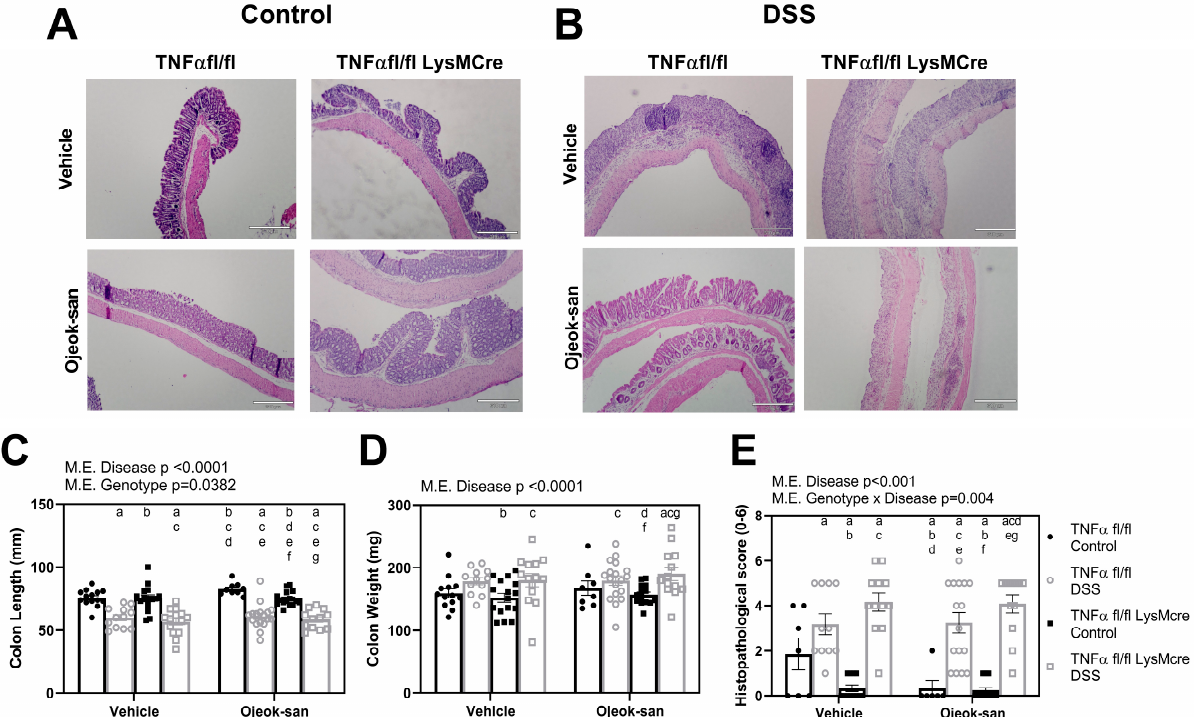
Figure 2. Ojeok-san administration does not impact colon size and histopathology in a chemical model of acute colitis. ( A ) Representative H&E staining of colonic tissue from control and ( B ) DSS- treated mice, ( C ) colon length, ( D ) colon weight, and ( E ) colonic histopathological score following acute DSS administration and OJS treatment in TNF α fl/fl and TNF α fl/fl-LysMCre mice. Values are represented as mean ± SEM; n = 8–18 mice per group. Three-way ANOVA followed by uncorrected Fisher’s LSD post hoc test. Letters indicate statistical significance ( p < 0.05) from a TNF α fl/fl Control- Vehicle, b TNF α fl/fl DSS-Vehicle, c TNF α fl/fl LysMcre Control-Vehicle, d TNF α fl/fl LysMcre DSS-Vehicle, e TNF α fl/fl Control-OJS, f TNF α fl/fl DSS-OJS, g TNF α fl/fl LysMcre Control-OJS. Goblet cells in the colon tissue were visualized using an Alcian blue stain (Figure 3A,B). The average number of goblet cells was determined per six crypts, and villus length was measured. DSS treatment was found to decrease villus length and goblet cell number in colitis mice (Figure 3C,D, p < 0.001). An interaction between disease and genotype was found to result in an increased villus length in TNF α fl / fl -LysMcre Control- Vehicle and OJS-treated mice, as well as TNF α fl / fl Control-OJS mice, relative to TNF α fl / fl Control-Ve- hicle mice, suggesting that TNF α deletion from macrophages has an impact on villus length ( p = 0.0443). An interaction between disease and treatment was found to decrease goblet cells in Control-OJS-treated TNF α fl / fl -LysMcre mice relative to Control-Vehicle- treated TNF α fl / fl -LysMcre mice ( p = 0.0133). However, no di ff erence was detected in the number of goblet cells between TNF α fl / fl Control-OJS and TNF α fl / fl DSS-OJS mice. DSS treatment was found to increase the gene expression of in fl ammatory genes, interleukin- 6 (IL-6) and nucleotide-binding oligomerization domain-containing 2 (NOD2) (Figure 3E,F, p = 0.022), but no signi fi cant changes were observed in terms of TNF α and interleu- kin-4 (IL-4) levels in the colon (Supplementary Figure S1). An interaction between disease and treatment was found to increase IL-6 expression in TNF α fl / fl -LysMcre DSS-OJS mice relative to all groups ( p = 0.0232).